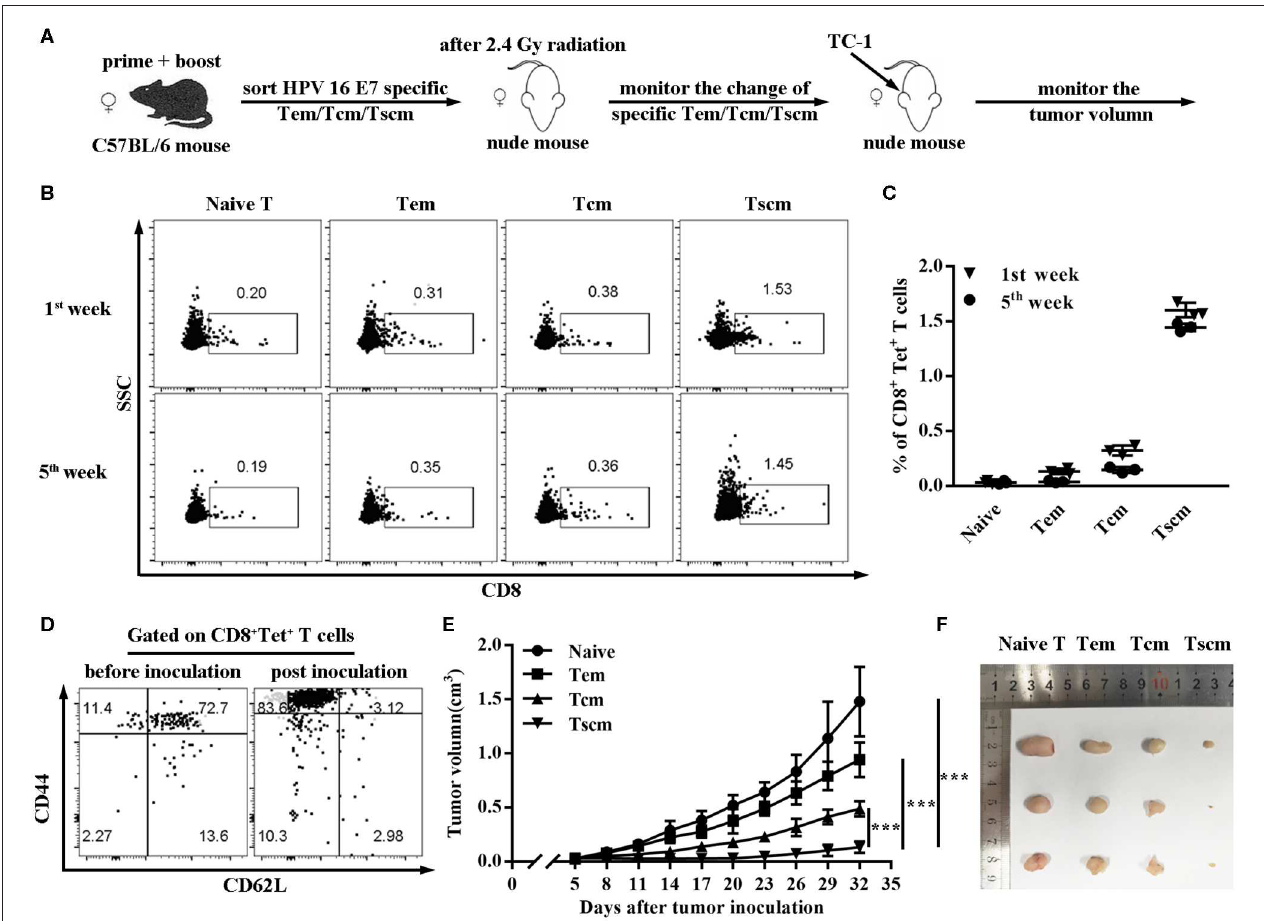
FIGURE 4 | Adoptive transfer of HPV16 E7 specific Tscm represses cancer growth . (A–C) Frequencies of CD8 + T cell in blood were measured by FCS analysis 1st and 5th week after injecting different subtypes of HPV-16 specific memory T cells (Tem, Tcm, Tscm) induced by immunized C57BL/6 mice into nude mice. (D) After injecting different memory T cells (Tem, Tcm, Tscm) induced by immunized C57BL/6 mice into nude mice, distributions of HPV16 specific CD8 + memory T cells in blood were measured by FCS analysis 1st and 5th week. (E,F) Nude mice ( n = 3 per group) after 2.4Gy radiation were injected with different memory T cells of the immunized mice and were inoculated (s.c.) with 1 × 10 6 TC-1 cells. Tumor growth was measured (two opposing diameters) and recorded once every 3 days. Data are representative of three independent experiments with similar results. *** p <